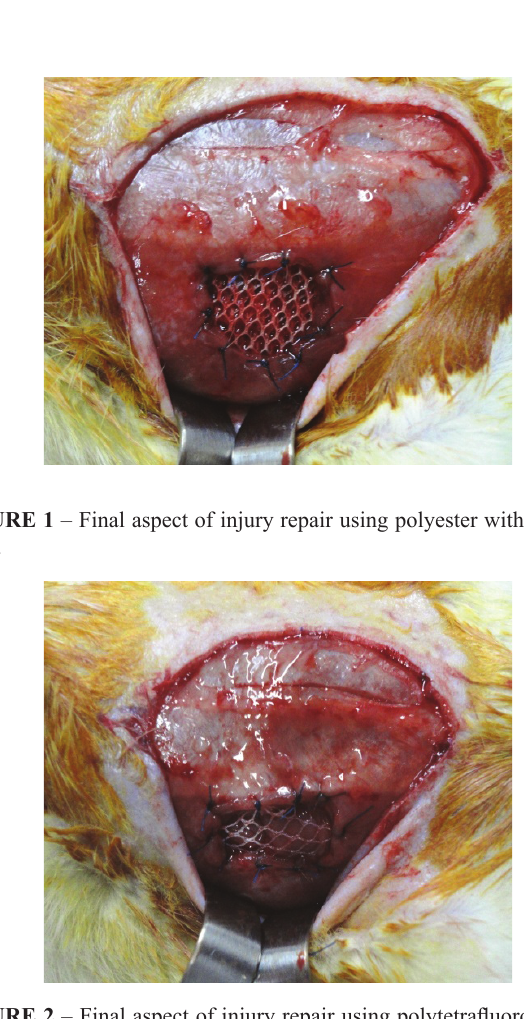
FIGURE 2 – Final aspect of injury repair using polytetrafluoroethylene mesh.